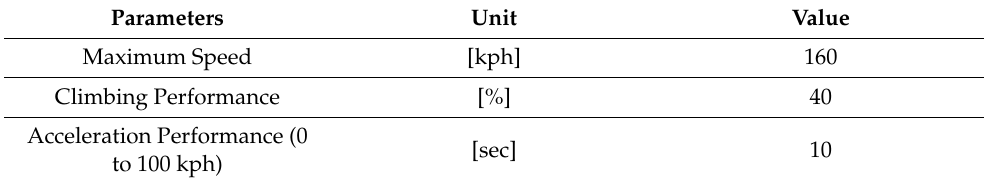
Table 4. Vehicle target performance.